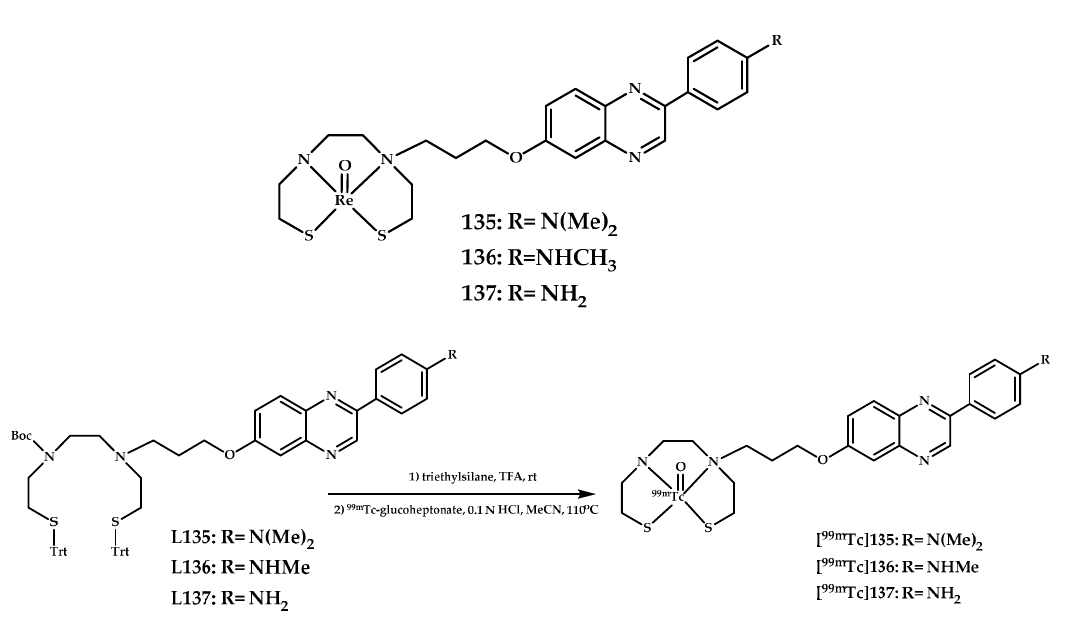
Figure 31. 99m Tc complexes [ 99m Tc]135–137 based on a phenylquinoxaline scaffold and their model Re(III) analogues 135–137, designed for SPECT imaging of A β plaques.